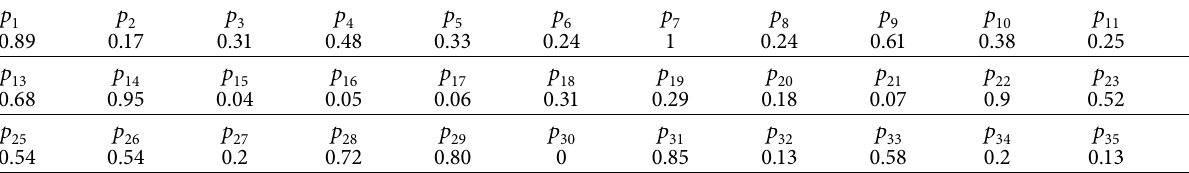
Table 5: Initial P value of every customer